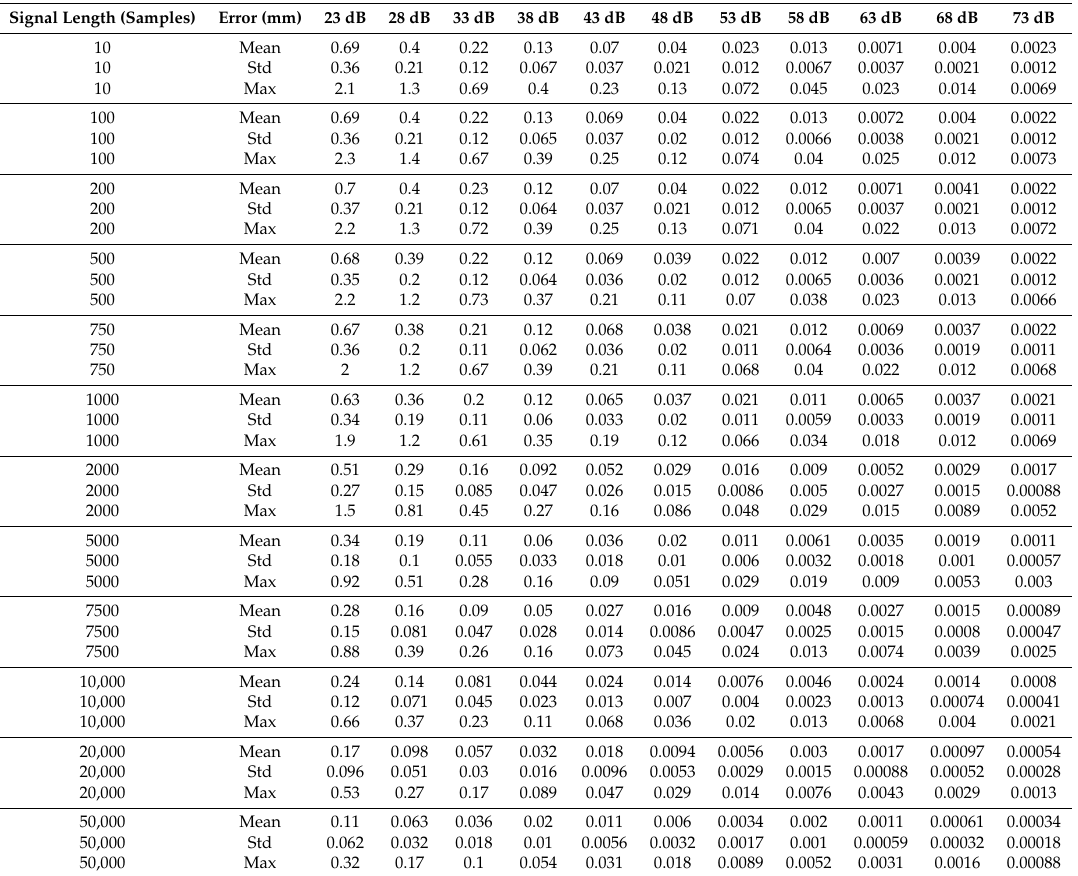
Table 4. Mean values, standard deviation, and maximum values of the mean error of the three emitters in the calculation of the reception point on the PSD surface using FDMA with IQ as a function of SNR and signal size.